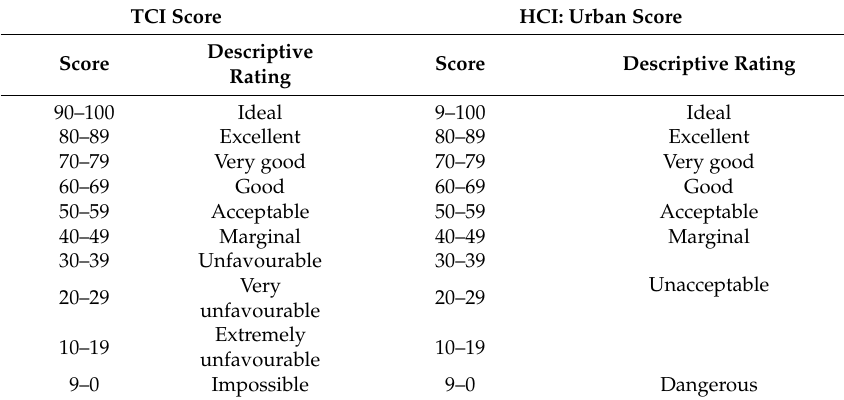
Table 2. Comparison of Tourism Climate Index (TCI) and Holiday Climate index (HCI:Urban) rating